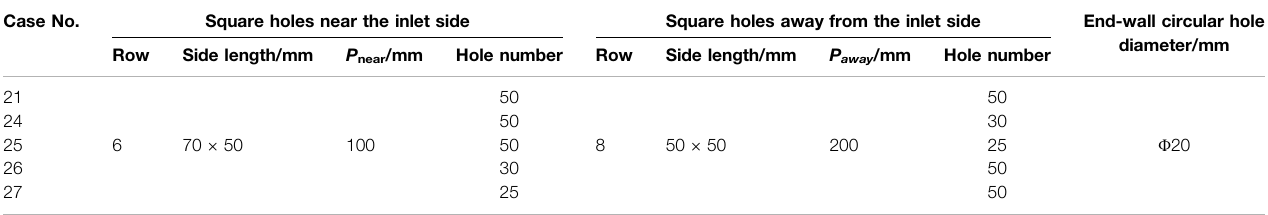
For the No.24 – 27 fl ow homogenizers, the numerical results of inter-unit fl ow rate distribution are shown in Table 10